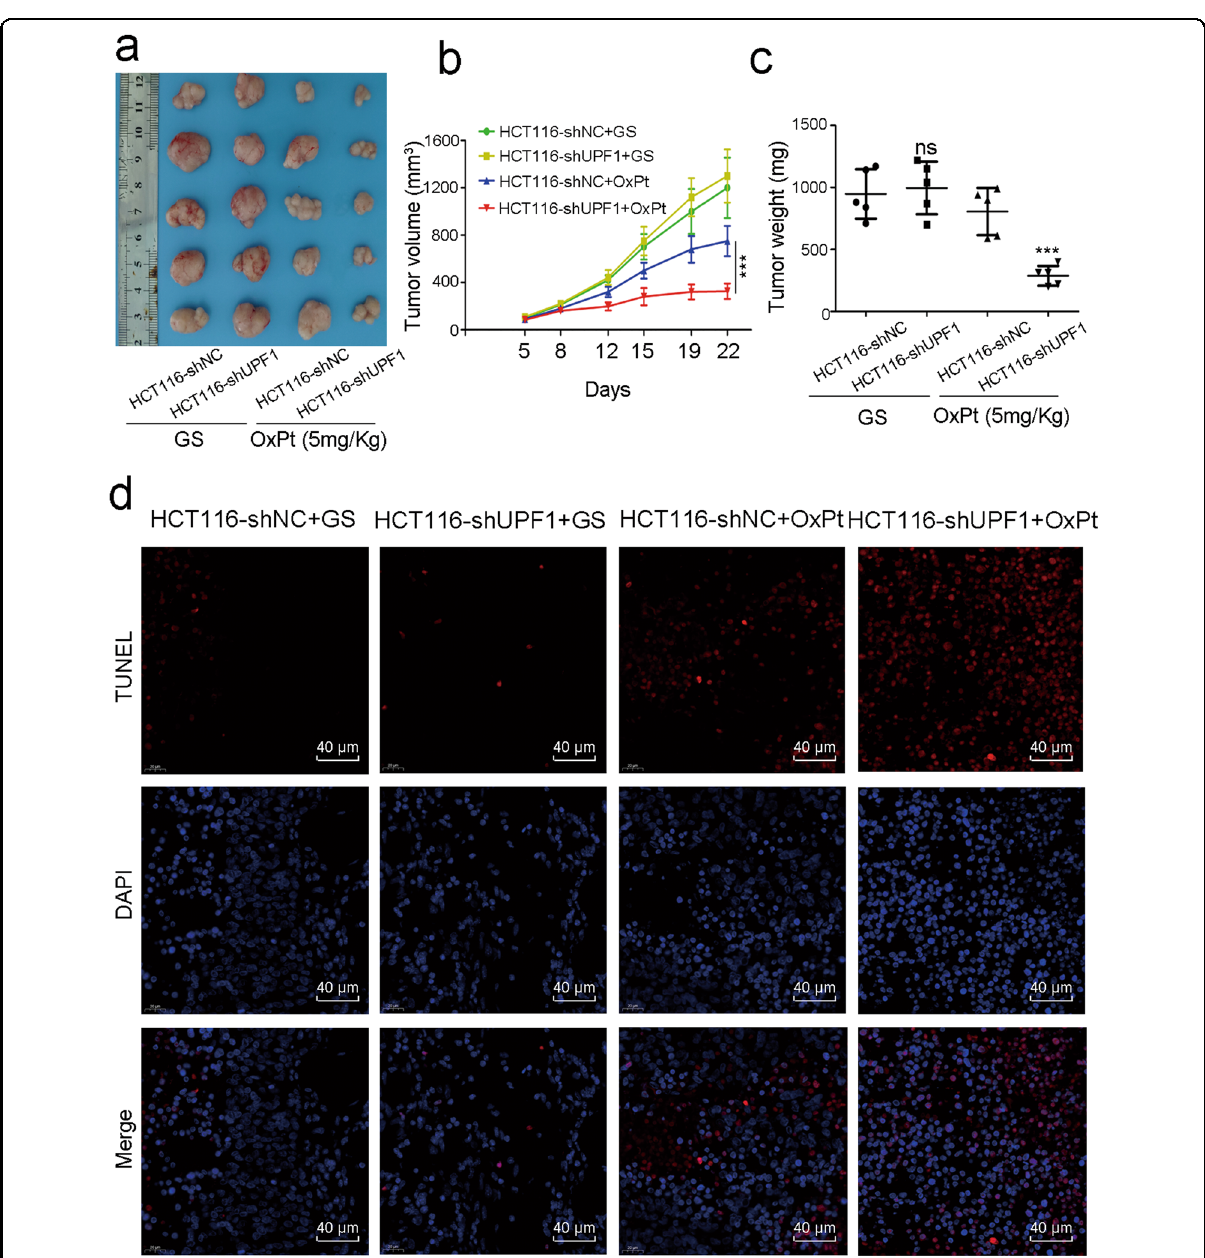
Fig. 3 UPF1 promoted chemoresistance to oxaliplatin in CRC in vivo. a Xenografts of HCT116-shNC and HCT116-shUPF1 treated with or without oxaliplatin. b Tumor volume in nude mice bearing HCT116 cells in different groups. Tumor volume equaled length × width 2 × 0.5 and was measured twice a week. c Tumor weight in nude mice bearing HCT116 cells in different groups. d TUNEL assay was performed to detect tumor cell apoptosis in xenograft tumor tissues, scale bar, 40 μ